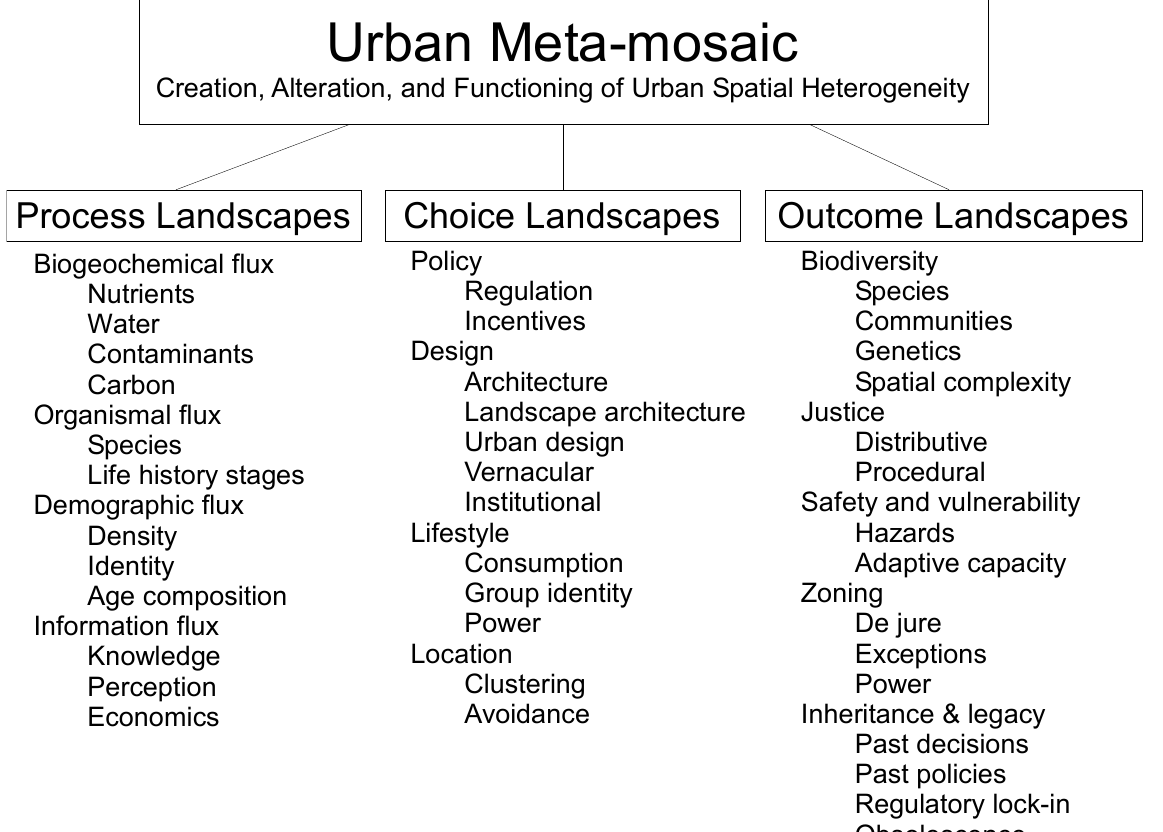
Figure 3. The urban meta-mosaic as a hierarchy of constituent mosaics or kinds of landscapes. The highest, most inclusive level both labels and describes the nature of a metamosaic for cities, suburbs, and exurban systems. The inclusive metamosaic comprises landscapes of process, landscapes of choice, and landscapes of outcome. Each kind of landscape is divided into specific realms and contributing phenomena. Courtesy of